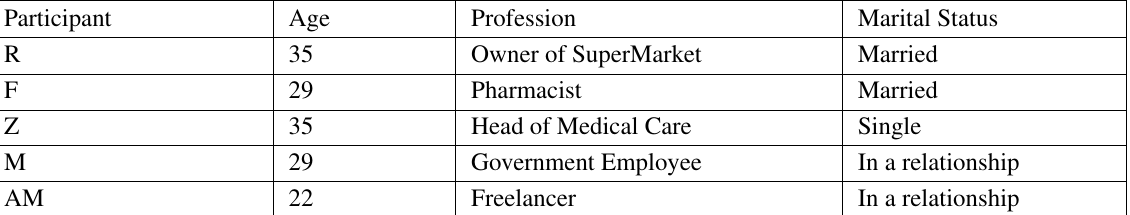
Table 1. Open Residential Area Residents